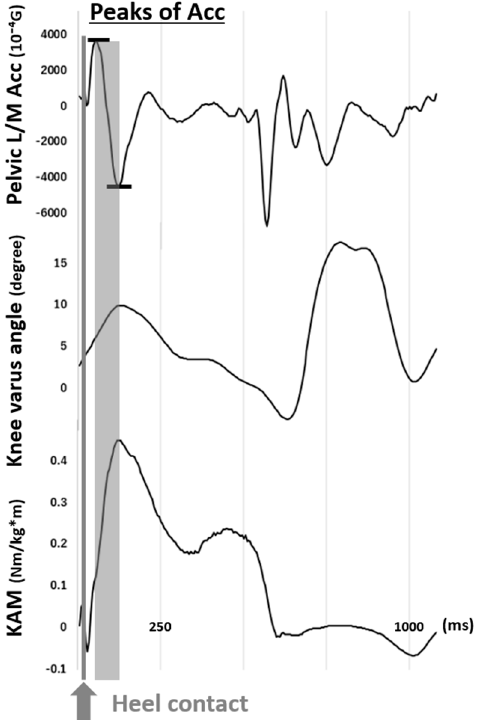
Figure 2. The synchronized data of the peaks of pelvic acceleration (Acc) in the lateral/medial (L/M) axis, knee varus angle, and knee adduction moment (KAM) from a representative case. (G = 9.81 m/s 2 ).